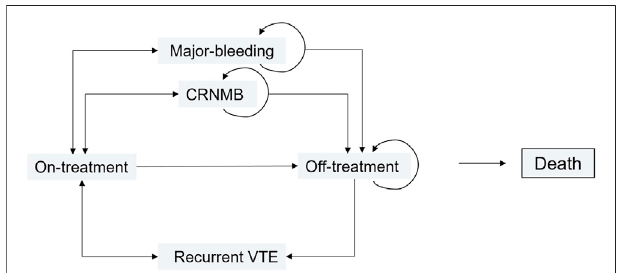
FIGURE 1 | Markov state transition